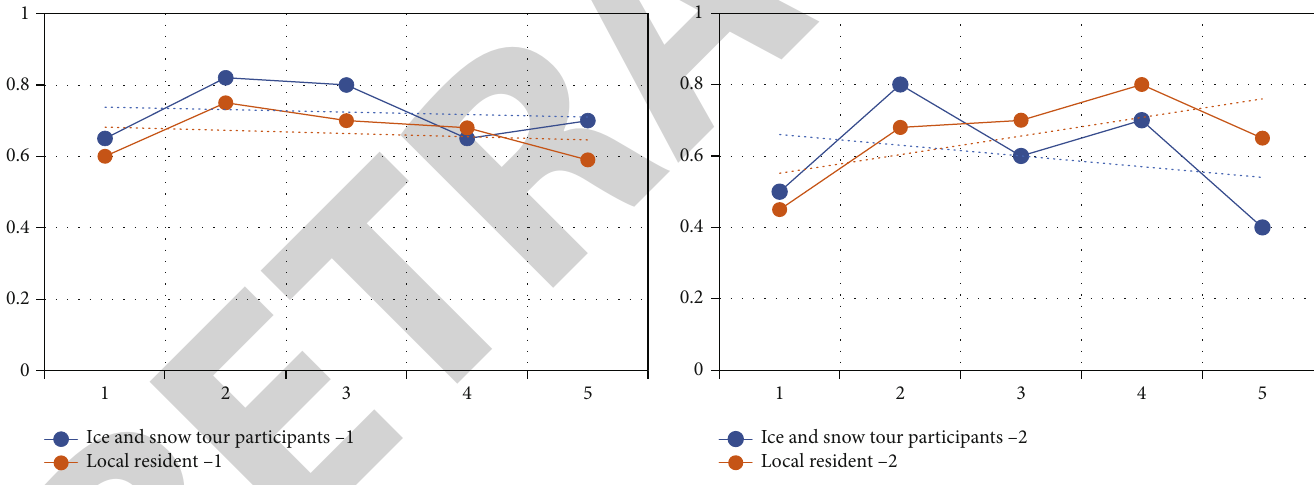
Figure 7: Income comparison chart of ice and snow tourism participants and local residents. Table 3: Age distribution of participants in ice and snow tourism. Age Number of